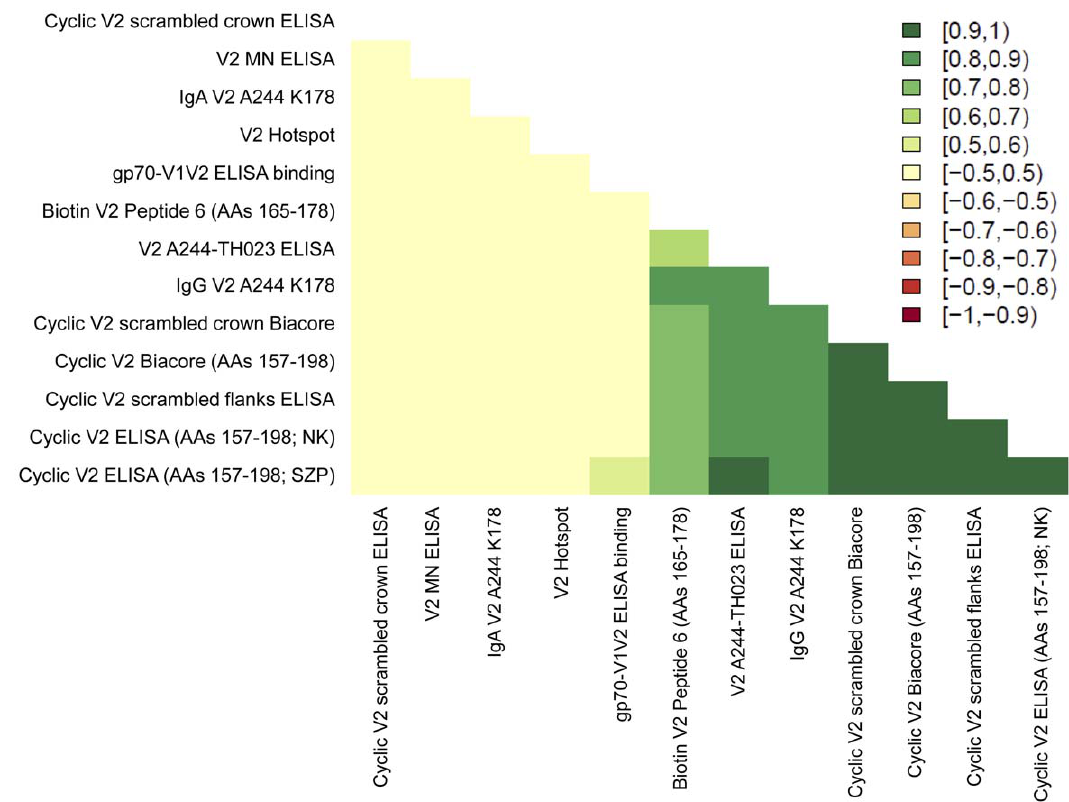
Figure 4. Spearman rank correlations between the V2 assays run in the case-control study.